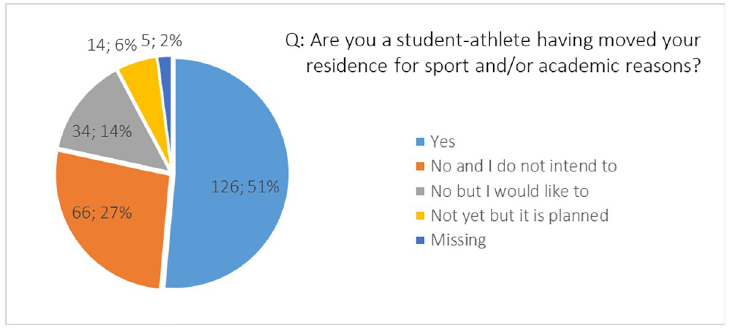
Fig 1. Distribution of respondents ( n ; %) with respect to migration experience and intentions.